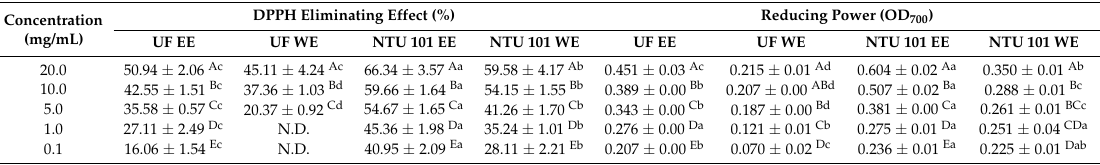
Table 1. The 1,1-diphenyl-2-picrylhydrazyl (DPPH) eliminating and reducing power activities of unfermented skim milk or NTU101FM extracts.